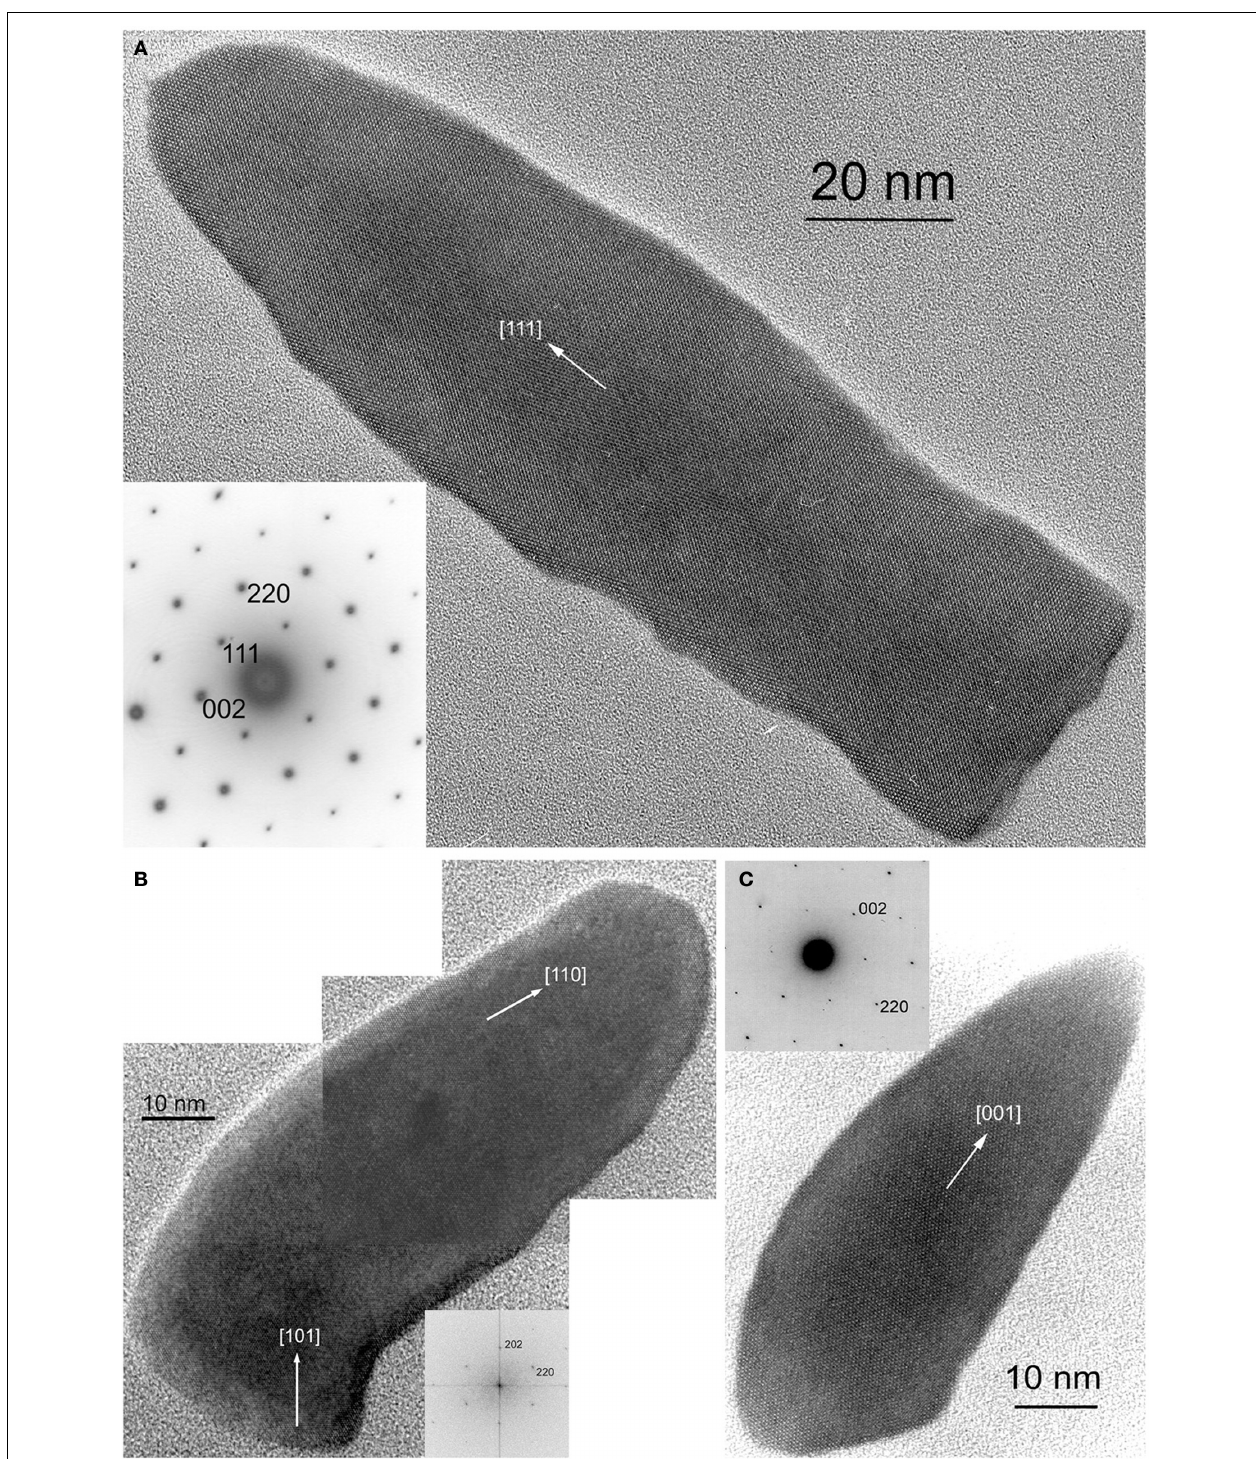
FIGURE 4 | HRTEM images of magnetite magnetosomes with highly anisotropic, elongated, pointed habits but different elongation directions. (A) A magnetosome from an unidentified freshwater rod, elongated parallel to [111], with the corresponding selected area electron diffraction (SAED) pattern in the lower left. (B) A composite image of a curved, fts magnetosome from the magnetotactic